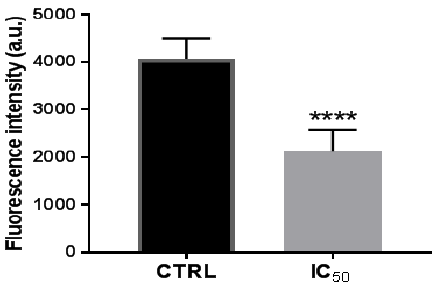
Figure 5. Proteasome 20 S activity in Caco-2 cells after incubation with onion extract at IC 50 (1000 p < 0.0001 vs. CTRL (untreated µg/mL) for 48 h. **** p < 0.0001 vs. CTRL (untreated cells). for 48 h. ****